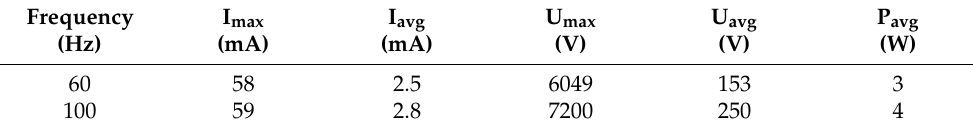
Table 1. Electrical parameters of the non-thermal plasma reactor.